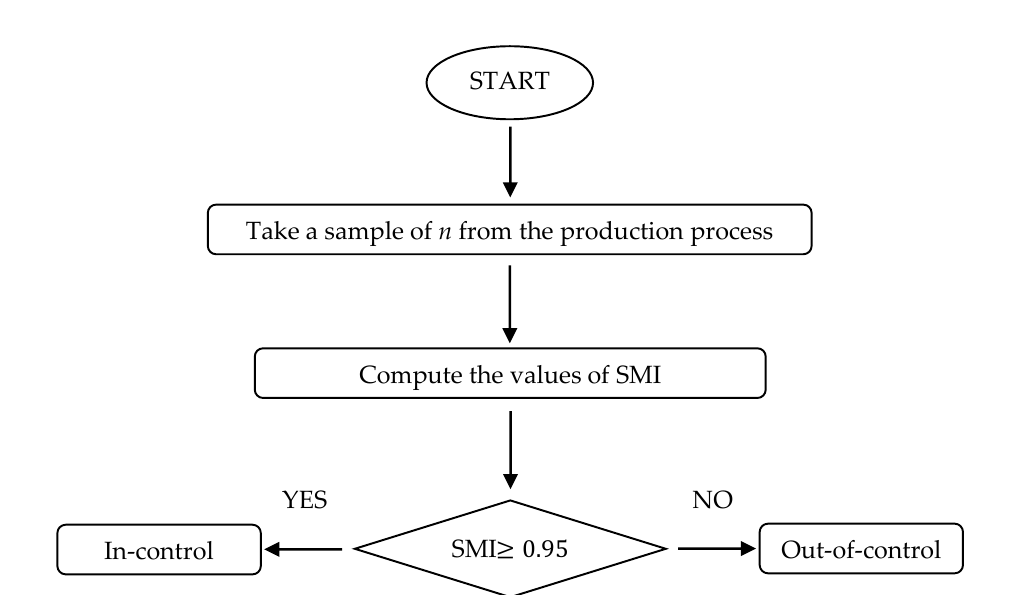
Figure 1. The operational process of the proposed